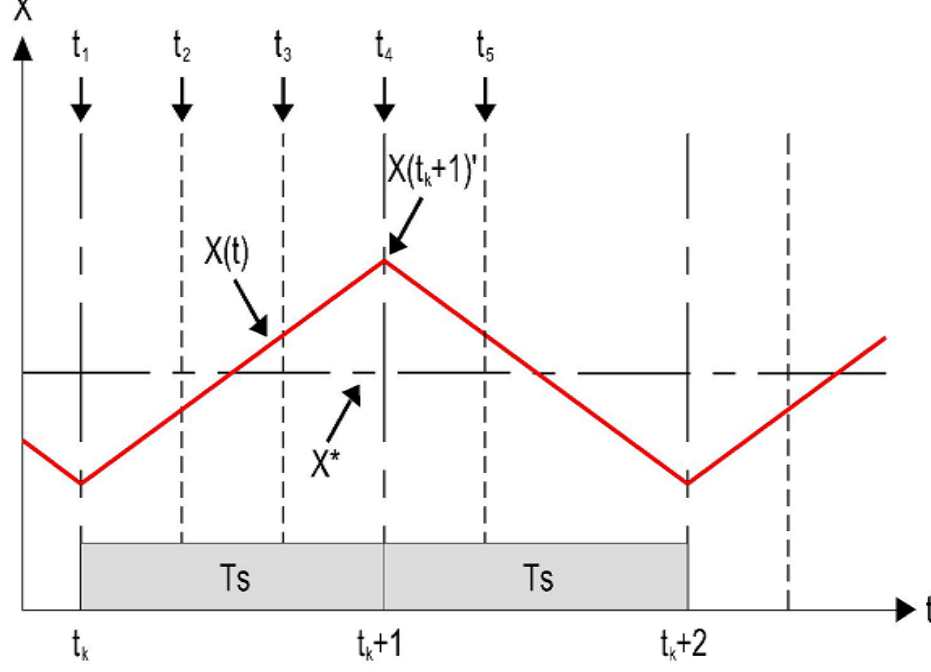
Figure 5. Processing data in a DSP.